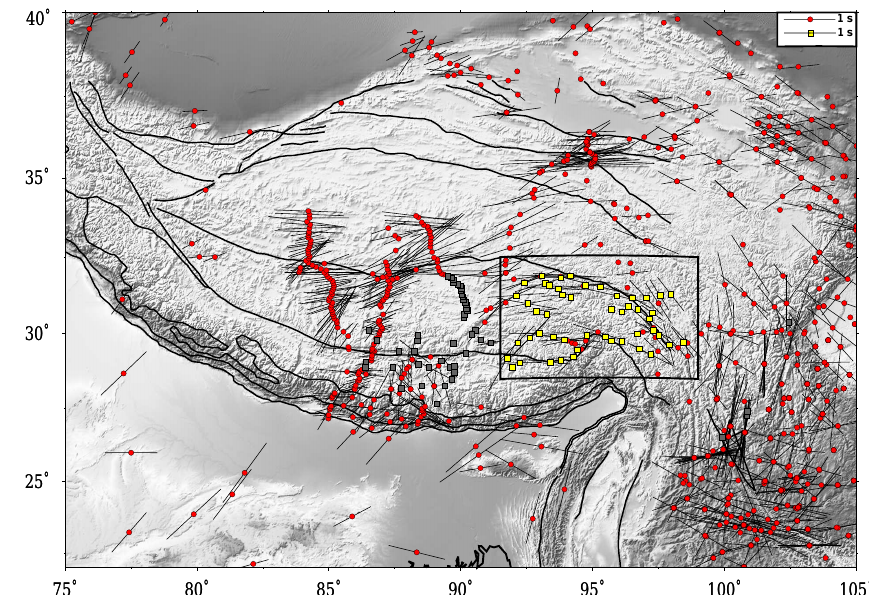
Figure 2. Earlier SKS and SKKS measurements in the study area (Sol et al., 2007; Wüstefeld et al., 2008). The length of solid bars shown for each seismic station is proportional to the splitting time delay ( δt s ), and their orientation represents the fast polarization direction ( φ s ). For clarity, the seismic stations used in the present study are shown by yellow-filled rectangles along with the SKS splitting measurements of Sol et al. (2007). Seismic stations where null or negligible anisotropy is reported in earlier studies (see Wüstefeld et al., 2008) are shown by grey-filled rectangles. All other stations are shown by red-filled